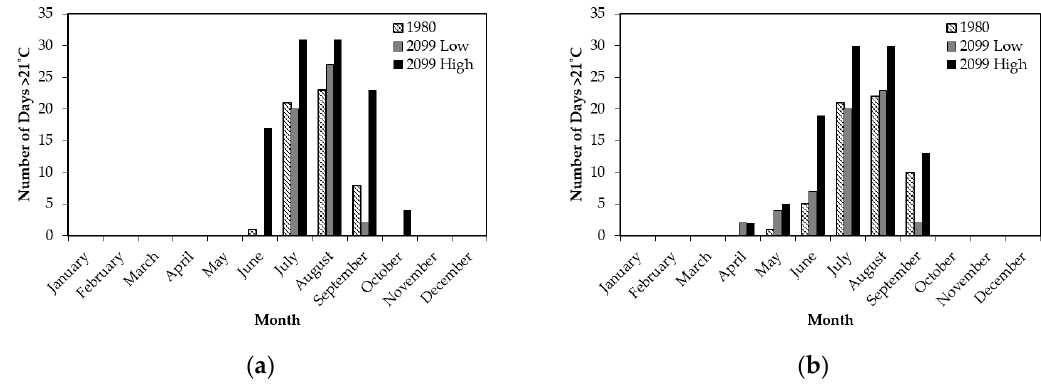
Figure 11. The number of days per month that stream temperatures exceeded the stress threshold in 1980, 2099 under low CO 2 emissions and 2099 under high CO 2 emissions in ( a ) the Beaver and Queen Rivers which had the same weather station and ( b ) Cork Brook.